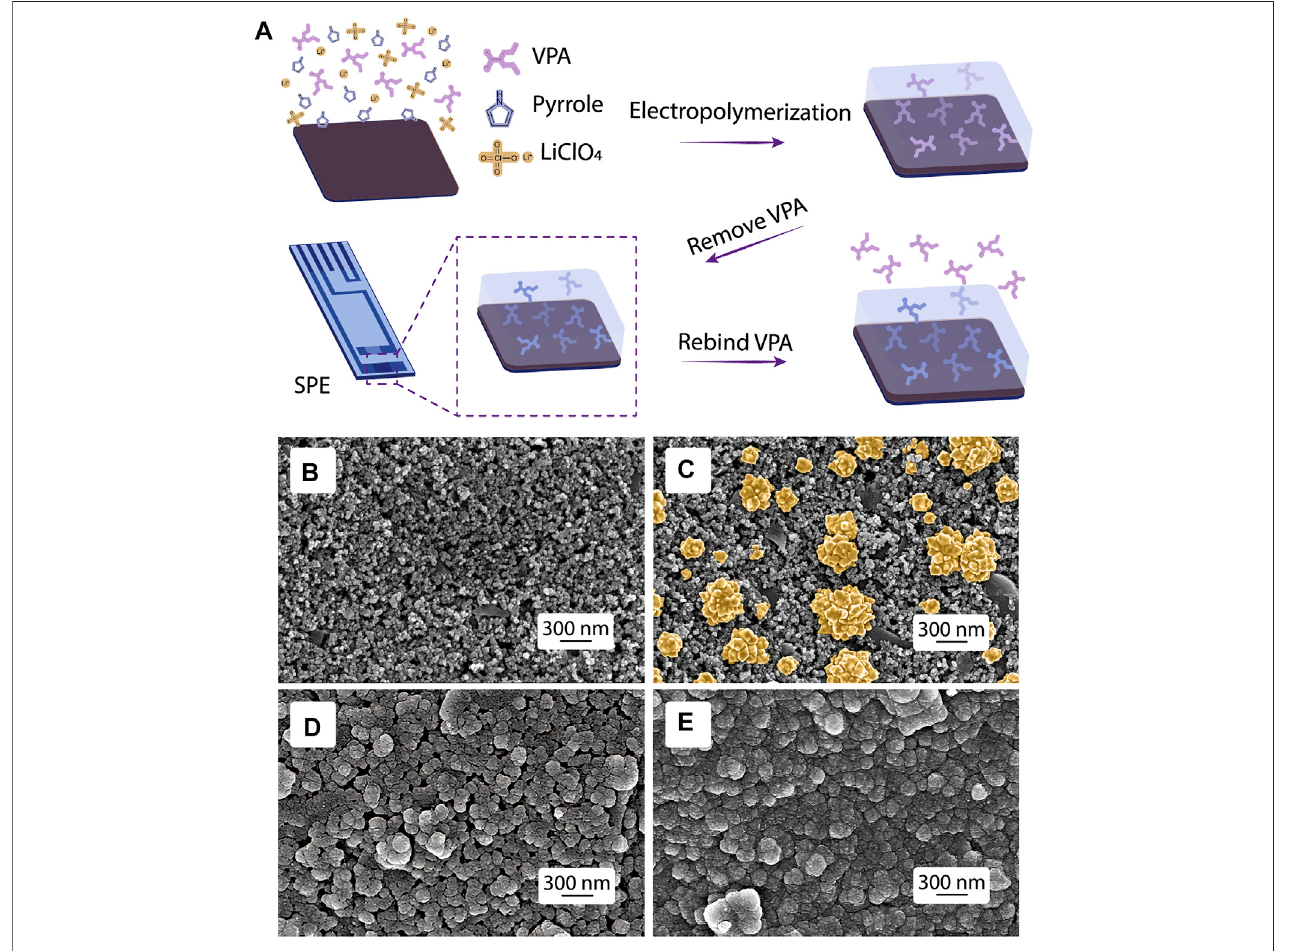
FIGURE 2 | MIP fabrication and morphology characterization. (A) Scheme of the MIP synthesis. SEM images of (B) bare SPE, SPEs modi fi ed with (C) AuNPs, (D) ppy@AuNPs-MIP, and (E) ppy@AuNPs-NIP.